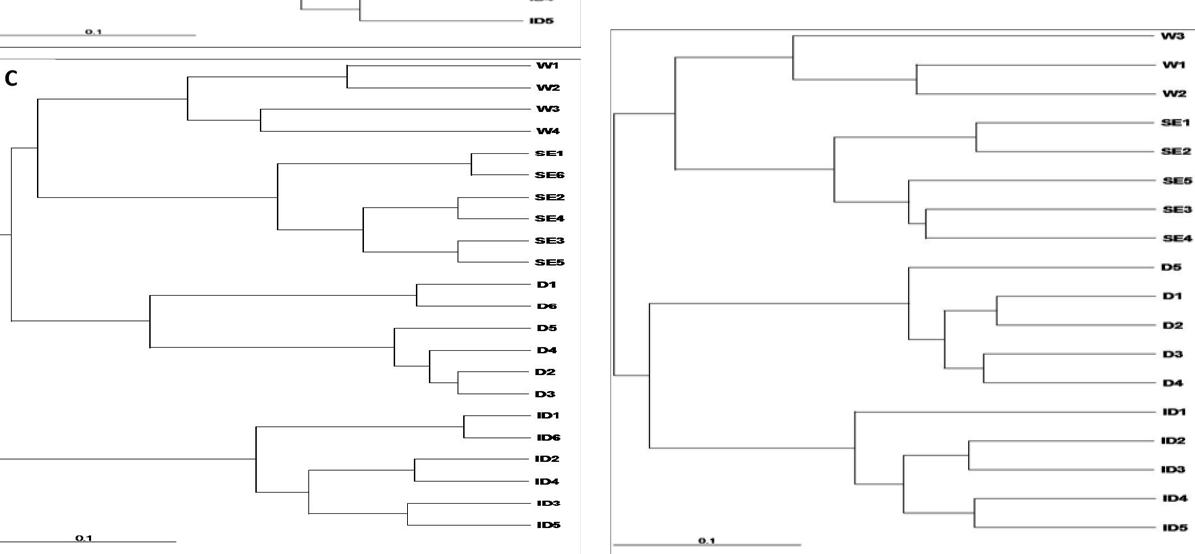
Fig. 4. UPGMA dendrogram generated using Jaccard similarity coefficient and 100 bootstrap for the genetic fidelity of in vitro regenerated shoots: SE=somatic embryogenesis, D=direct organogenesis, ID=indirect organogenesis) in comparison to W=wild plants, based on the combined data analysis of ISSR, RAPD and cpSSR